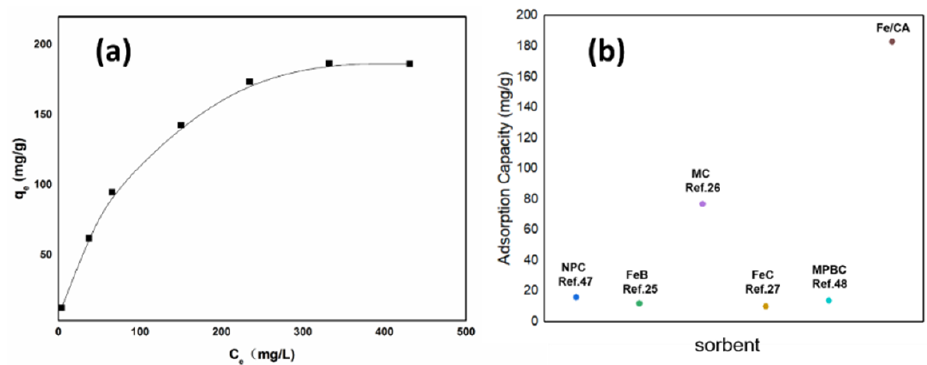
Figure 9. The adsorption isotherm ( a ) of Fe/CA and the comparison of Cr (VI) adsorption capacities for different adsorbents ( b ).